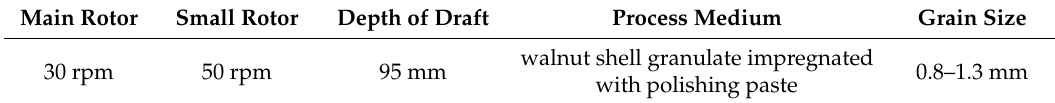
Table 2. Parameters of drag finishing.